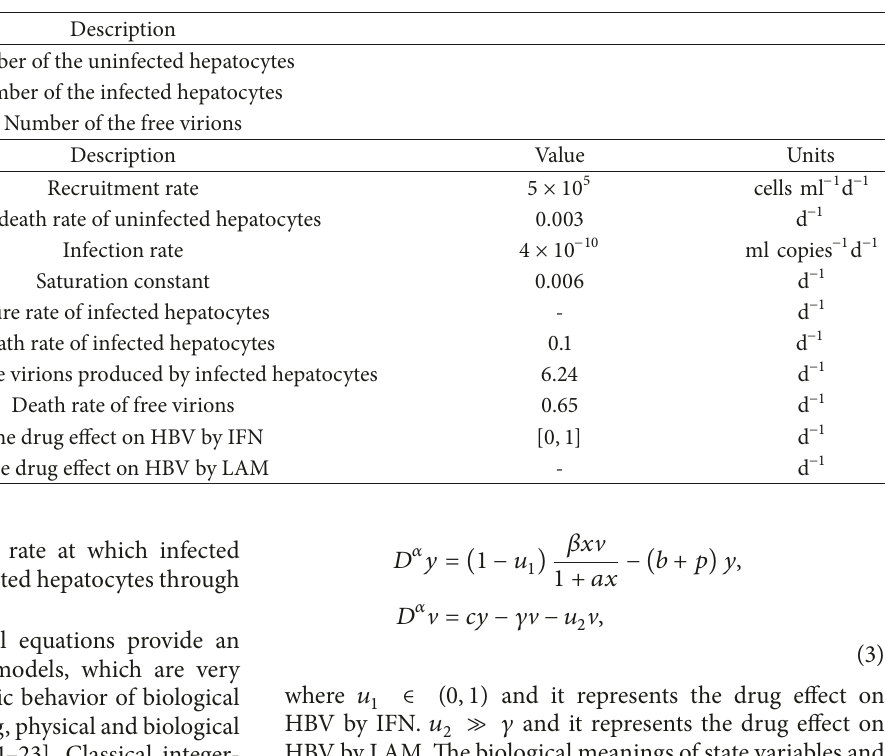
Table 1: The biological meanings for state variables and parameters for system